Question: Which kind of chart has been used to present this data?
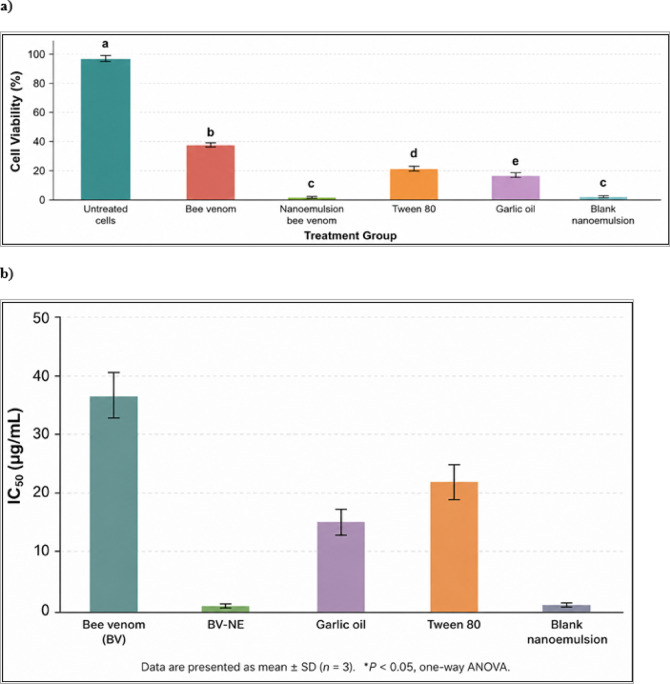
Answer: bar